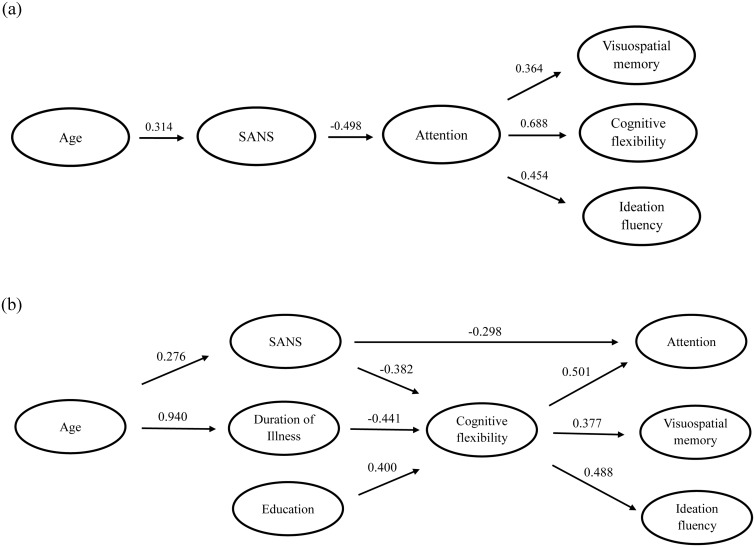
The multiple regression analyses for relationships between clinical features and cognitive domains in DS and NDS group, respectively.Note: The relationships between clinical variables and cognitive domains impairments in (a) DS group and (b) NDS group were carried out with the hierarchical regression analyses. The numerical values represent standardized beta weights.